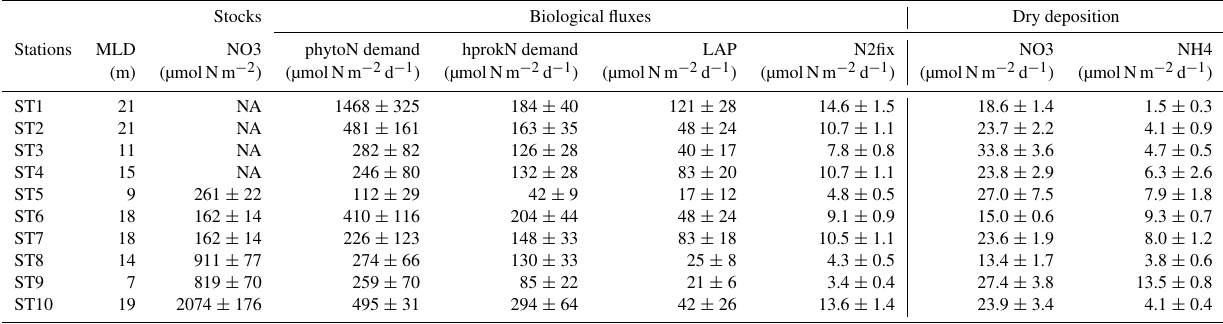
Table 2. N budget at the short stations within the surface mixed layer (ML): integrated stocks (NO3, µmolNm − 2 ) and fluxes (heterotrophic prokaryotic N demand (hprokN demand), phytoplankton N demand (phytoN demand), in situ leucine aminopeptidase hydrolysis fluxes (LAP), N 2 fixation rates (N2fix), and dry atmospheric deposition of NO3 and NH4 (all fluxes in µmolNm − 2 d − 1 ) ). Values presented as mean ± SD. SD was calculated using propagation of errors: for hprokN demand triplicate measurements at each depth and a C / N ratio of 7 . 3 ± 1 . 6; for phytoN demand triplicate measurements of PP at each depth and a C / N ratio of 7 ± 1 . 4; for LAP the analytical TAA error and the V m and K m errors; for N2fix the coefficient of variation of 10% for volumetric fluxes > 0 . 1nmolNL − 1 d − 1 and 20% for lower values. For dry deposition, SD is based on the variability in the NO3 and NH4 concentrations solubilized from aerosols during the occupation of the station (see “Materials and methods”, Sect. 2.2.1). MLD: mixed layer depth. NA: not available because not sampled for LWCC analysis and below detection limits using standard nutrient analysis.